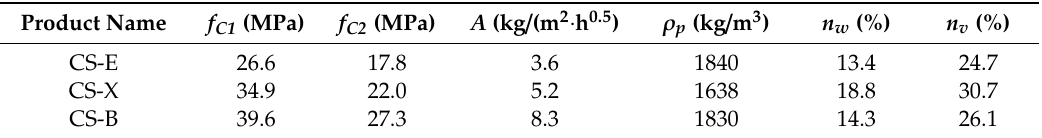
Table 1. Comparison of the average values of the main parameters characterizing individual groups of tested silicate